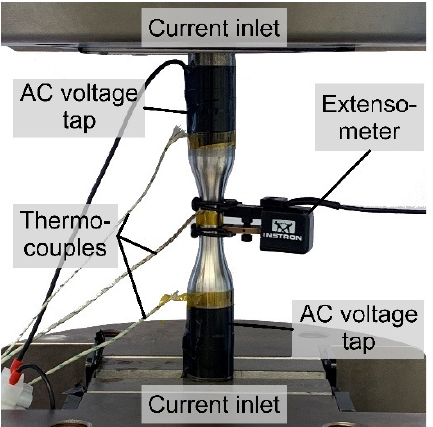
Figure 6. Experimental setup for mechanical testing.